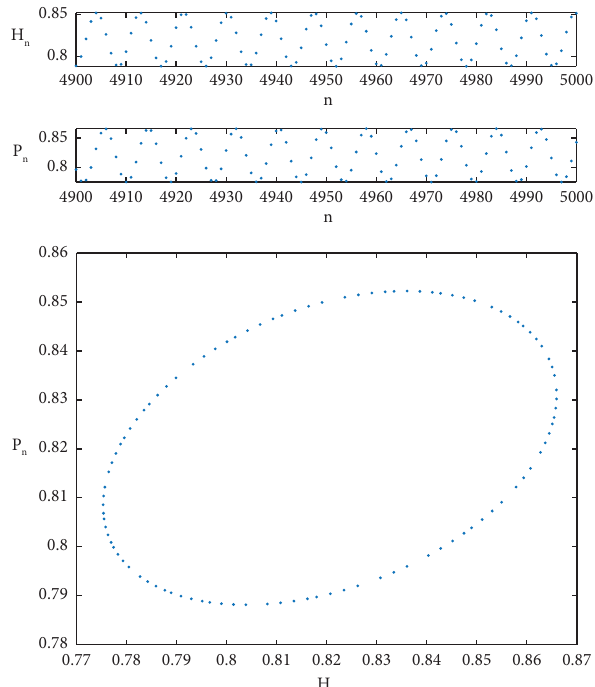
Figure 4: When R � 2 , k � 1 , c � 0 . 8 , σ ∗ � 0 . 278652 , ( H ∗ , P ∗ ) � ( 0 . 819753 , 0 . 819753 ) , system (37) undergoes a Neimark-Sacker bi- furcation at σ � σ ∗ . Parasite and host populations are maintained in a state of periodic